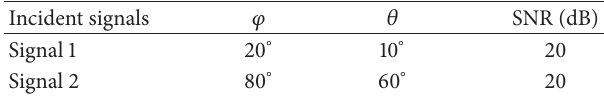
Figure 8: Spatial spectrum of DOA estimations for three incident signals employing the circularly polarized microstrip array.